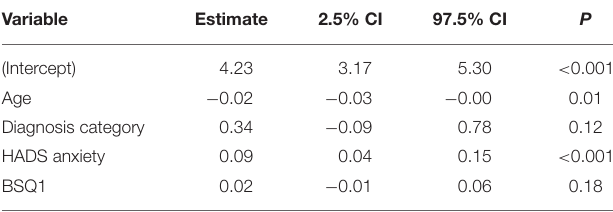
TABLE 3 | Principal component analysis (PCA) of healthcare providers.